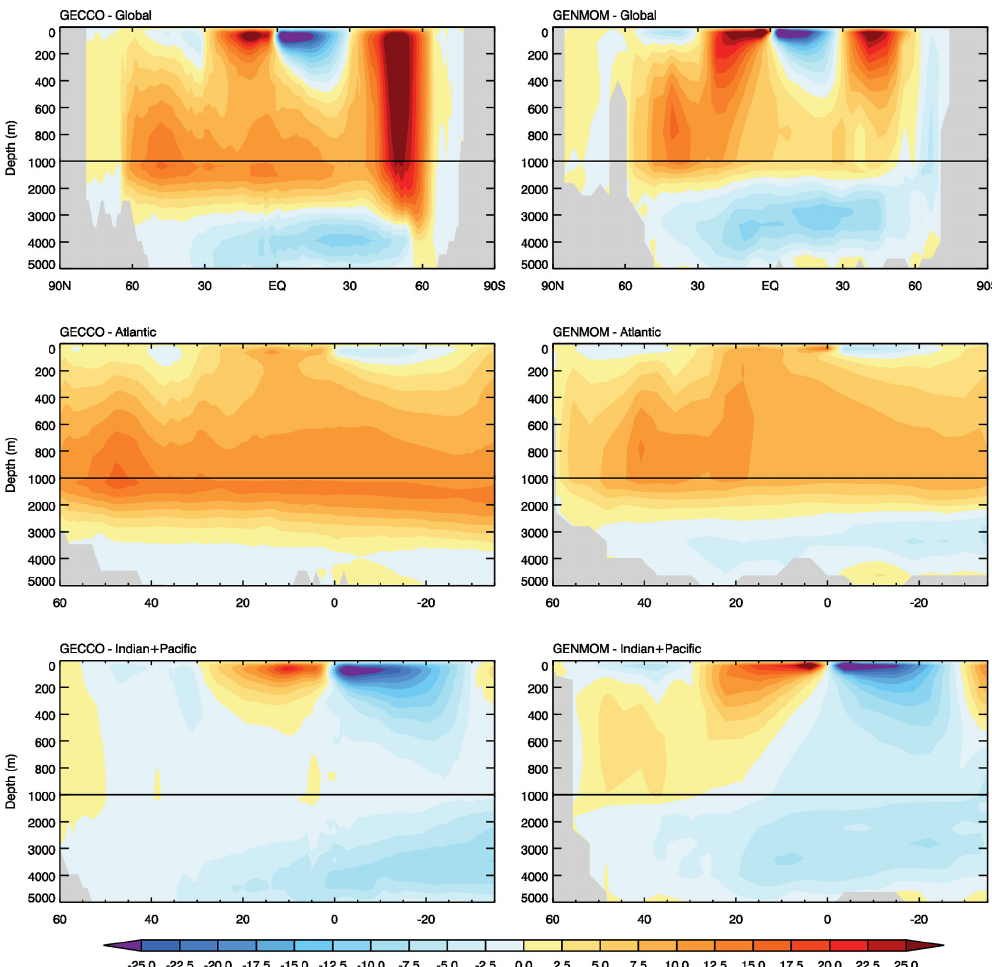
Fig. 9. Ocean overturning for both observed (GECCO) and simulated (GENMOM, full 300-year simulation) globally (top), Atlantic Ocean (middle), Indian and Pacific Oceans